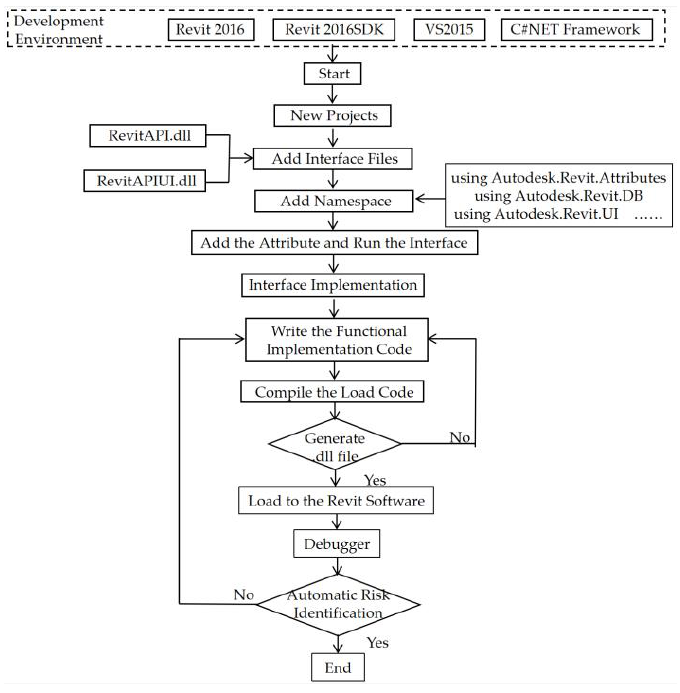
Figure 9. Revit secondary development process.